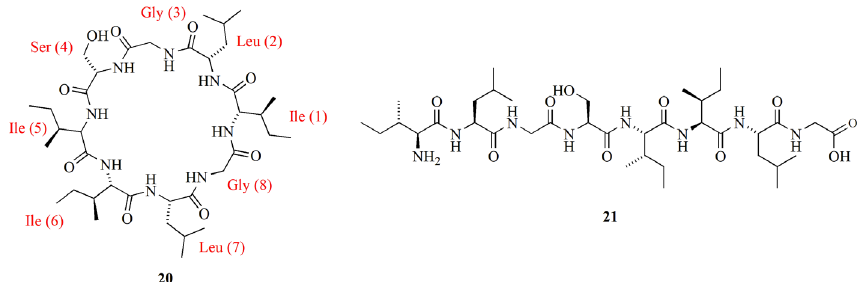
Figure 7 - Ribifolin ( 20 ), orbitide isolated from Jatropha ribifolia , and its linear derivative ( 21